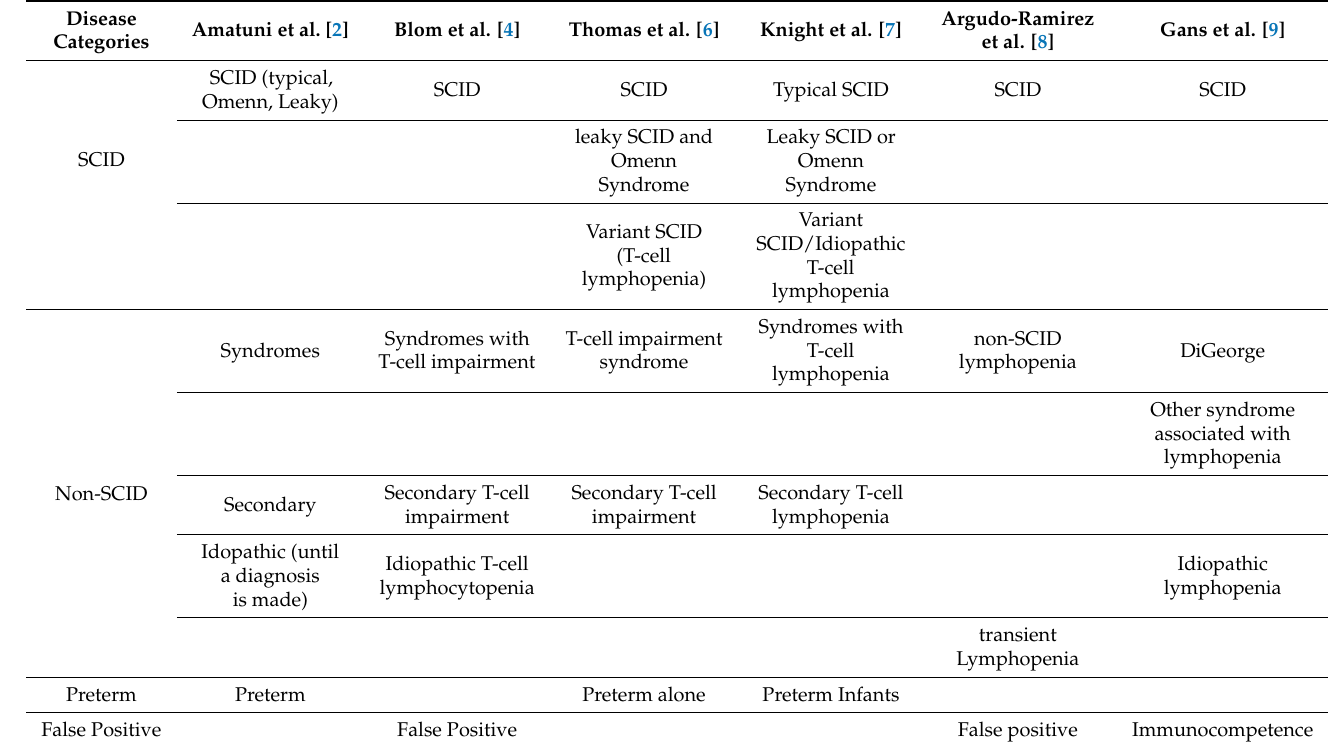
Table 1. Disorders considered screen positive cases in six newborn screening